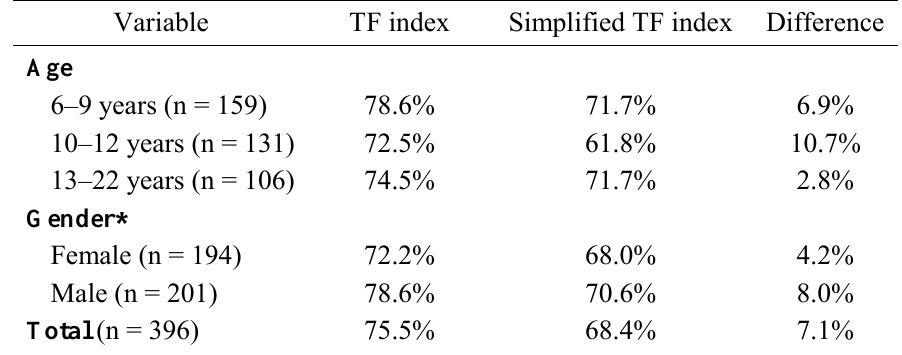
Table 1. Prevalence of dental fluorosis according to age and gender using the full mouth TF index and the simplified TF index, rural communities,